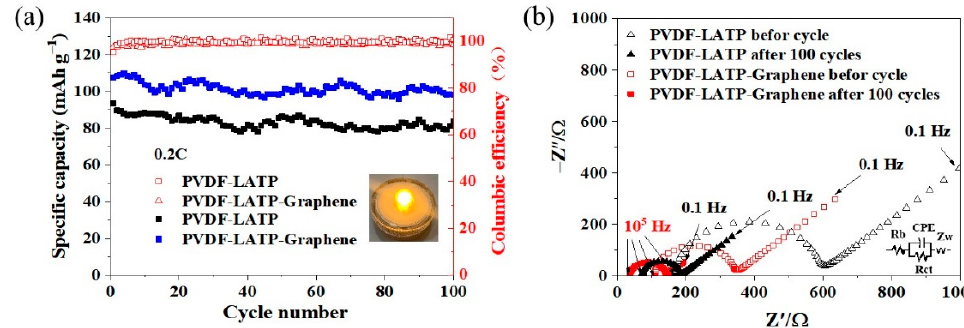
Figure 7. ( a ) Cycling stability and coulomb efficiency of LFP/PLL/Li and LFP/PLLG/Li at 0.2 C and ( b ) EIS diagram of LFP/PLL/Li and LFP/PLLG/Li before and after 100 cycles.